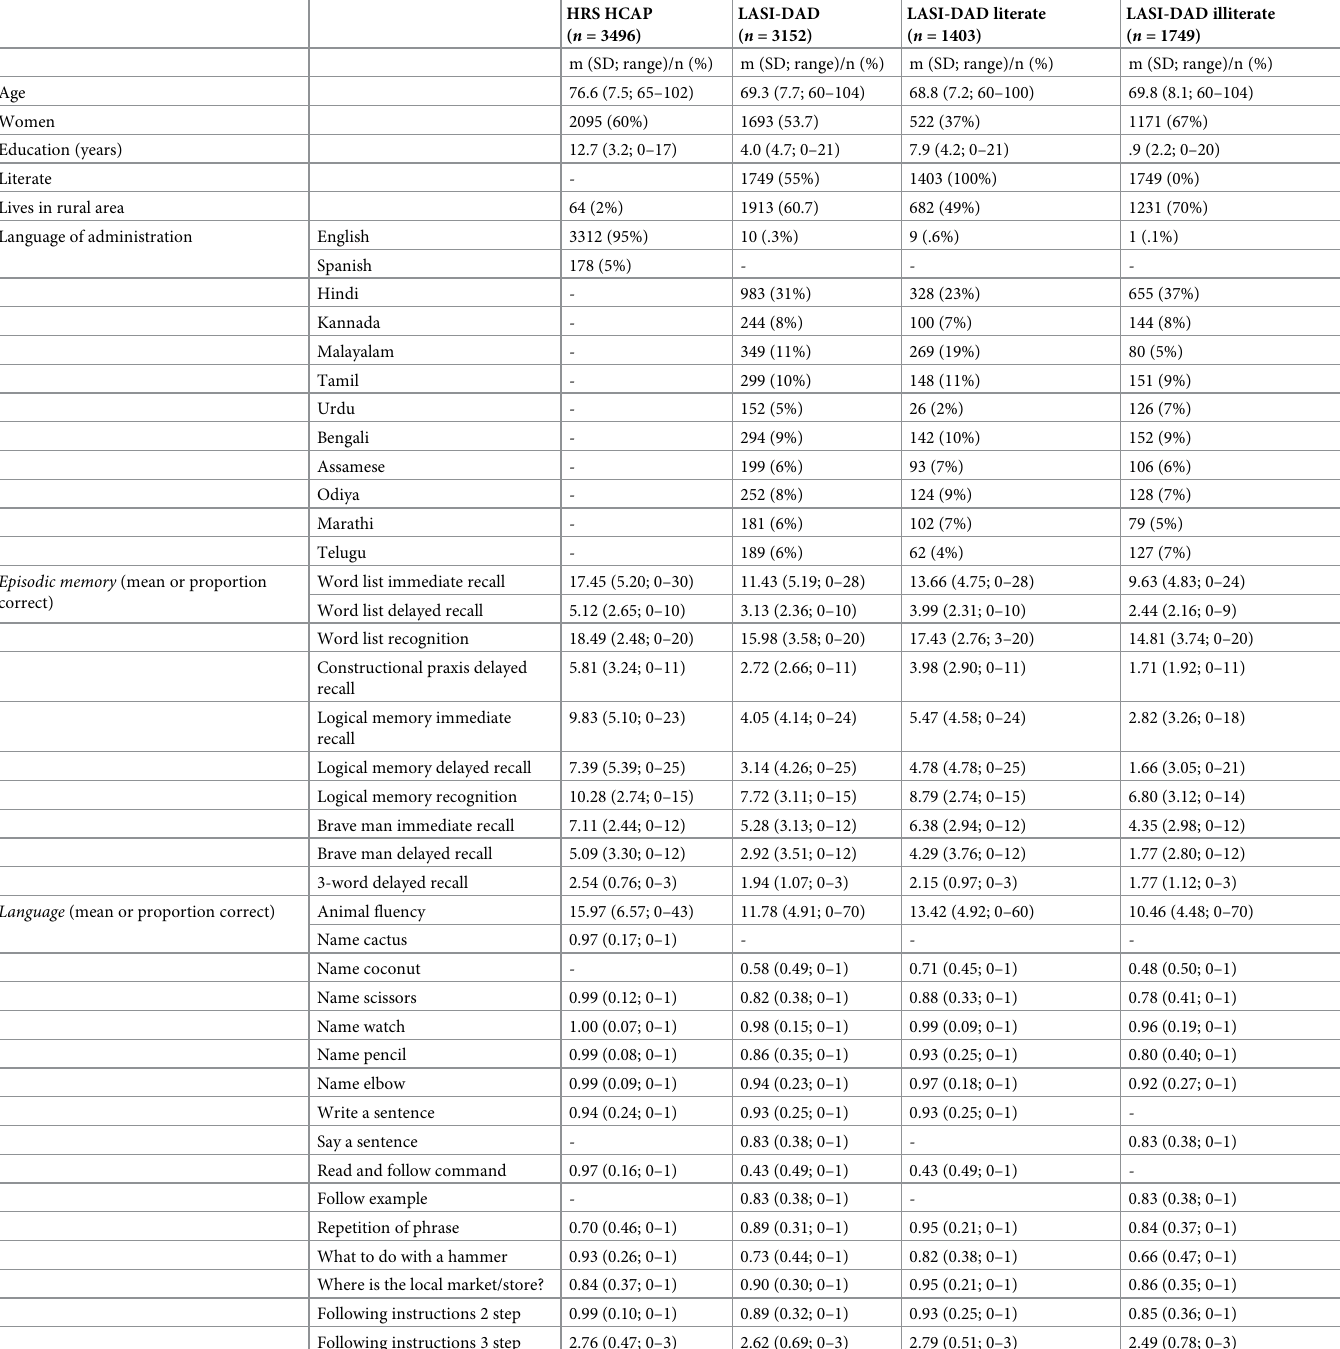
Table 2. Sample characteristics for HRS HCAP and LASI-DAD (overall and stratified by